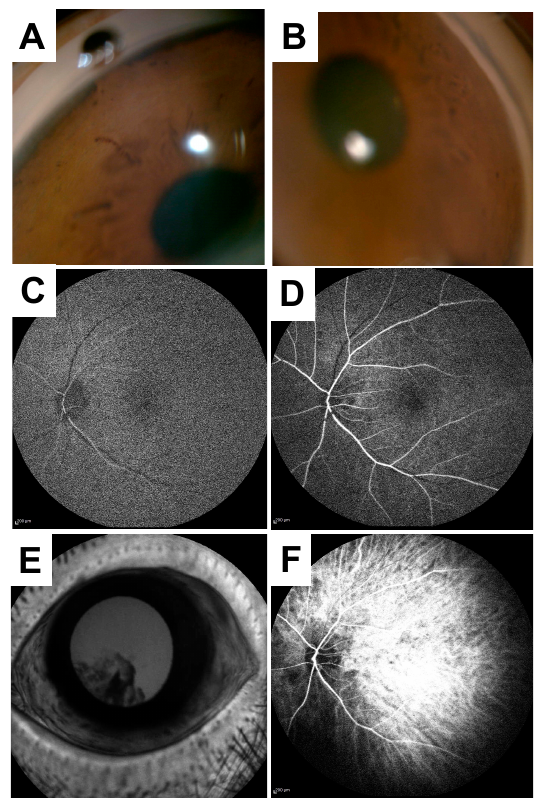
Figure 4. Gonioscopy, fluorescein, and indocyanine green angiography findings 3 months after the baseline visit. A gonioscopy photo of the left eye ( A ) and showing no rubeosis iridis ( B ). Fluorescein angiography (FA) of the left eye shows no delays in the following: the choroidal flush was 16 s ( C ), the arm-to-retina time was 18 s ( D ), and the retinal circulation time was 10 s. There was no leakage in